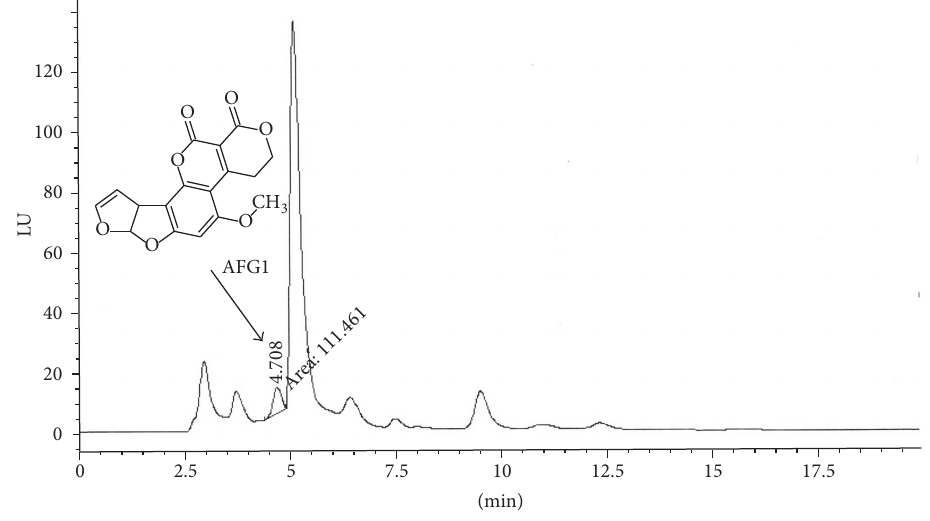
Figure 2: HPLC chromatogram of unpacked fennel